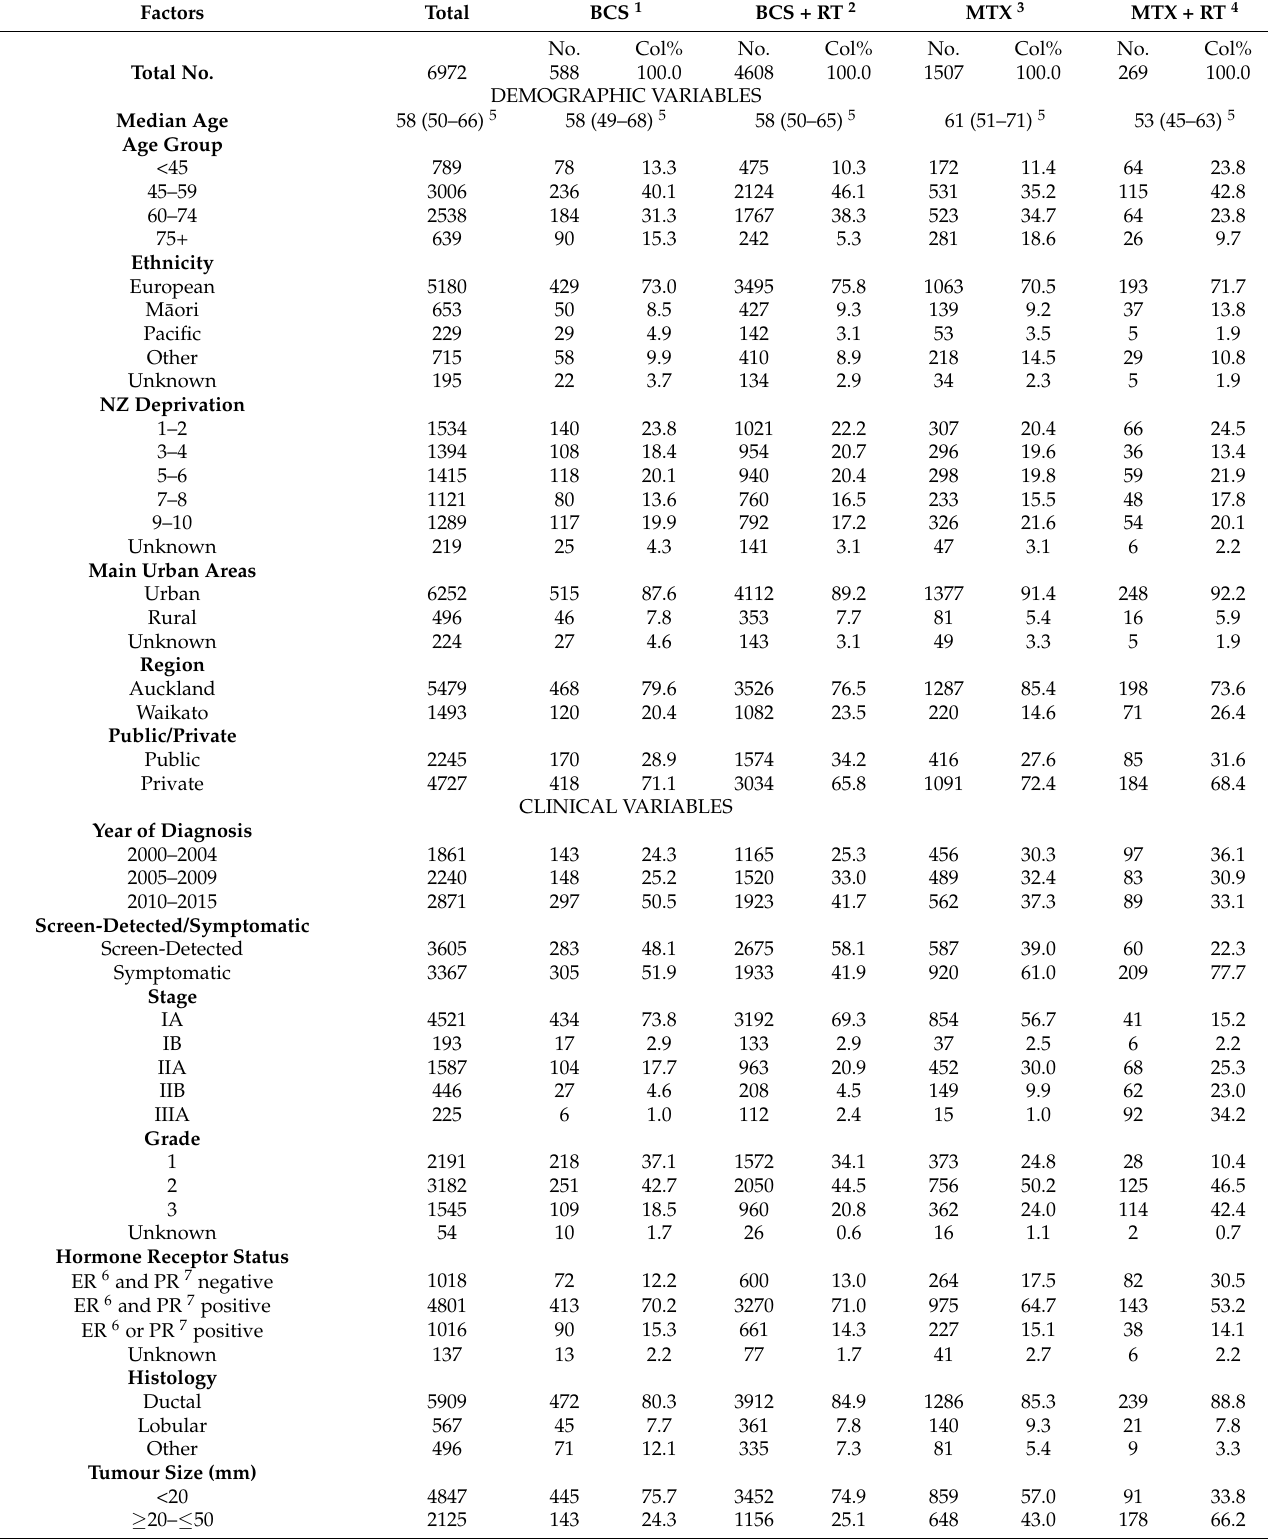
Table 2. Baseline characteristics of surgical treatment groups by demographic, clinical and systemic treatment variables (See Appendix A, Table A1 for table with row